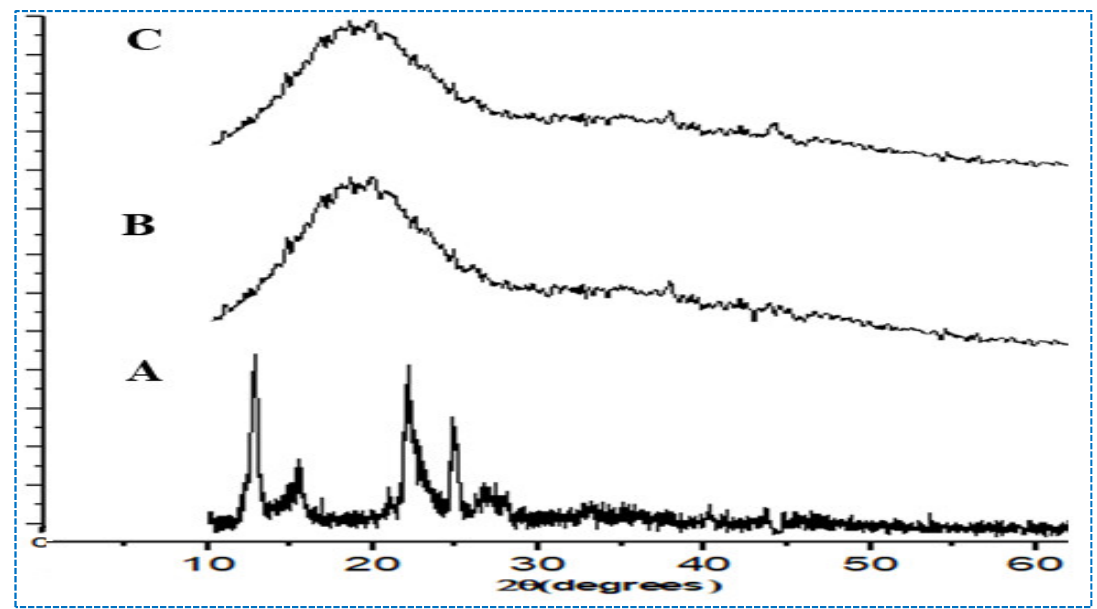
Figure 7. XRD spectra of pure ALG ( A ), Eudragit ( B ), and optimized ALG-NPs ( C ).